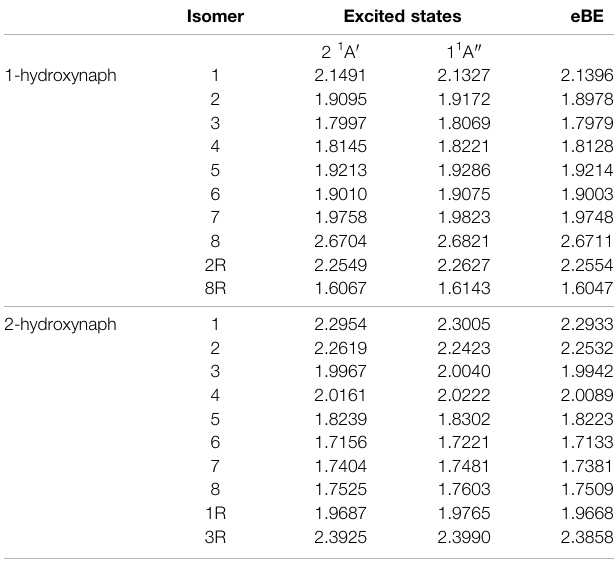
TABLE 6 | The singly deprotonated ethynylnaphthalene anion derivatives eBEs and transition energies.